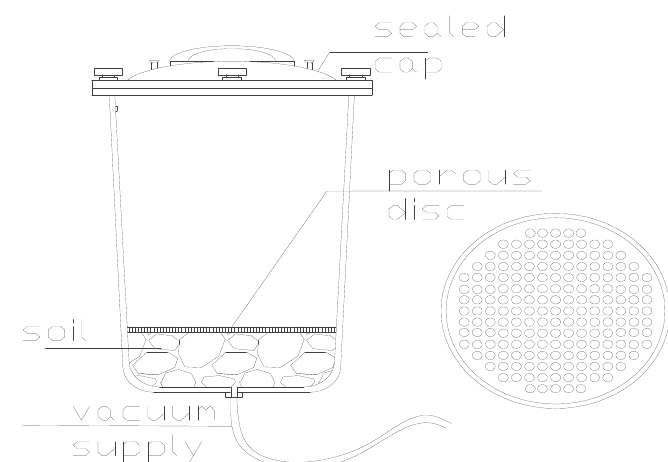
Figure 1. Vacuum preloading equipment.